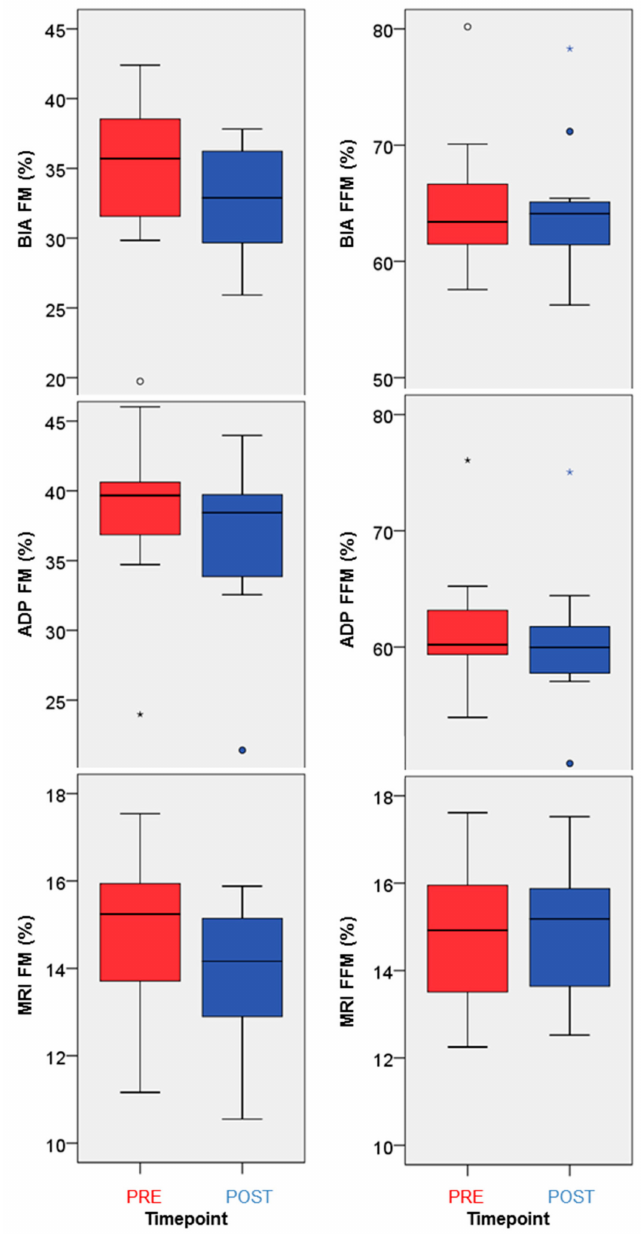
Figure 3. Box plots fat mass ( right ) and fat-free mass ( left ) as percentage of the body weight measured by BIA ( top ), ADP ( center ) and MRI ( bottom ). X-axis labels before diet are ‘PRE’ and after six weeks are ‘POST’ values. MRI data restricted to the imaging volume, BIA and ADP values for the whole body. Extreme values are represented by circles (‘out’) and asterisks (‘far out’). Abbreviations: FFM = fat-free mass, FM = fat